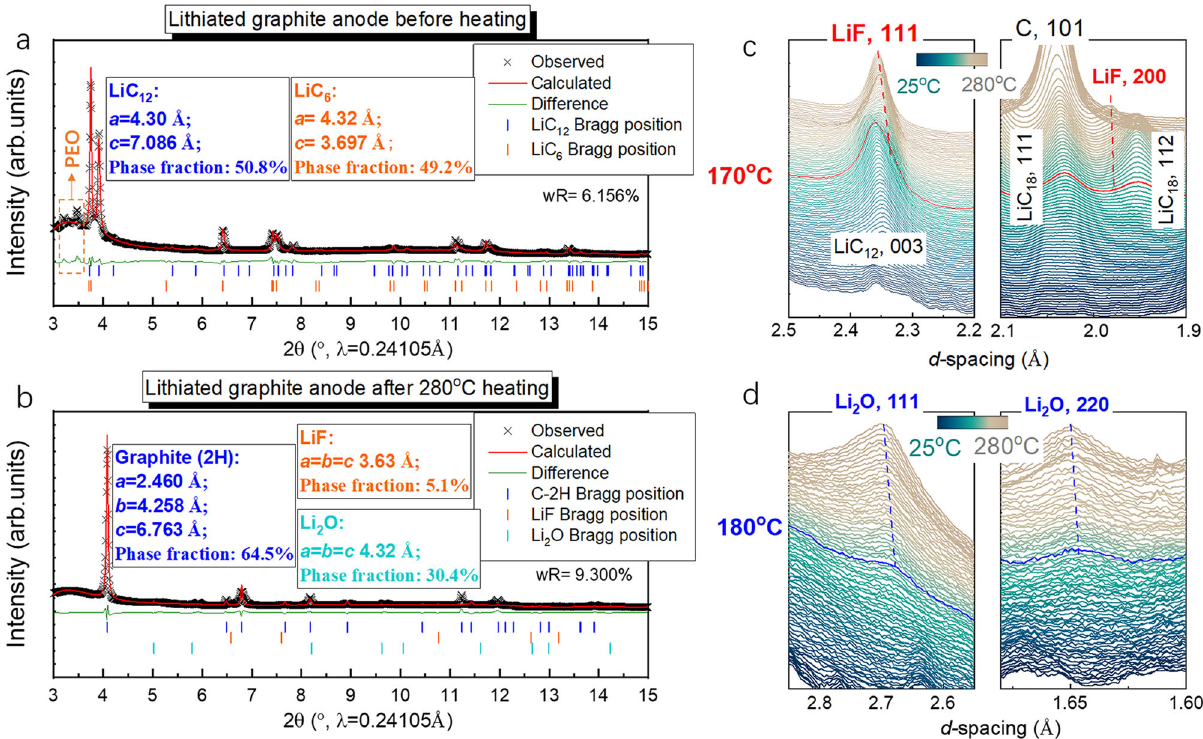
Fig. 2 The LiF and Li 2 O formation during the heating process. a The Rietveld re fi nement of lithiated anode before heating. b The Rietveld re fi nement of lithiated anode after heating to 280 °C. c The formation of LiF by tracing the LiF (111) and (200) Bragg re fl ections. d Li 2 O formation by tracing the Li 2 O (111) and (220) Bragg re fl